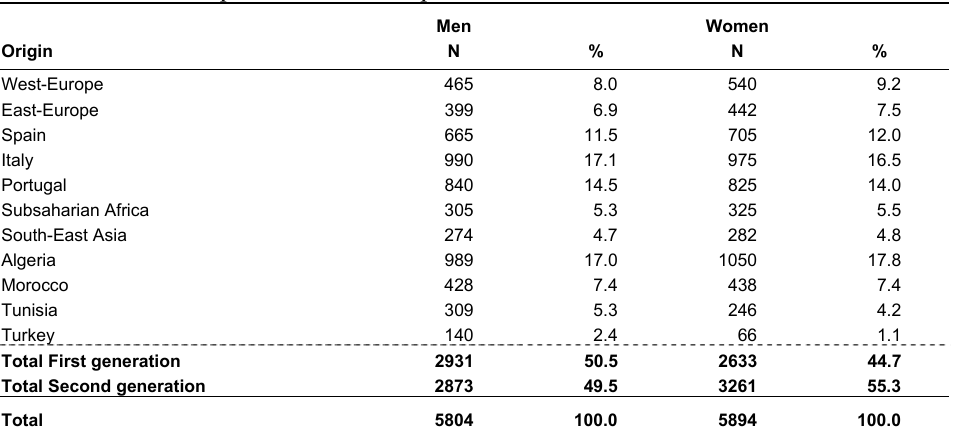
Table A 1: The composition of the